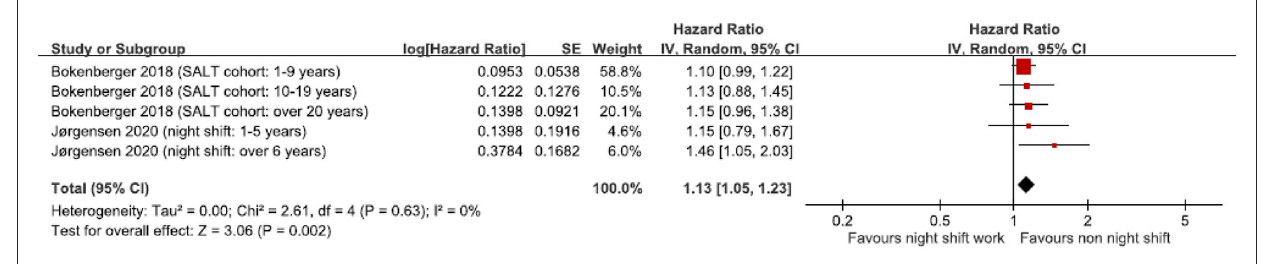
FIGURE4 Subgroup analysis of hazard ratio of dementia based on night shift work over 1 year. CI, confidence interval.